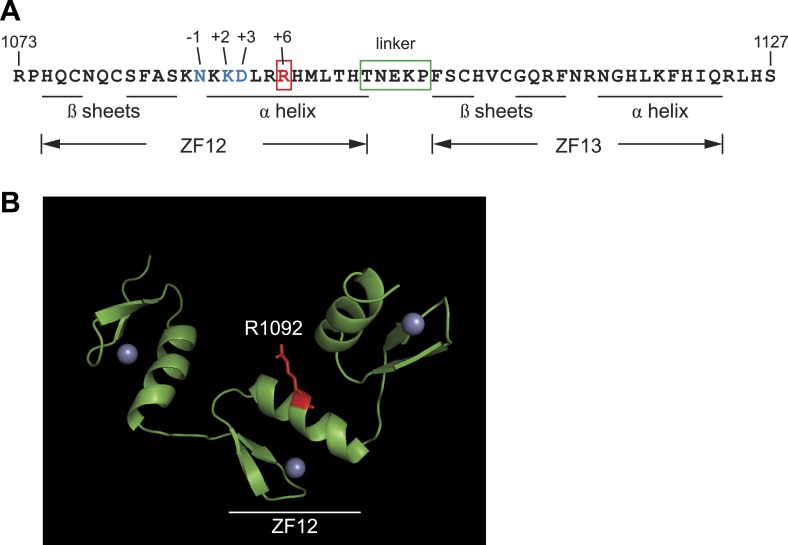
Protein sequence analysis and structural modeling of mutated C2H2
zinc finger in Zfp335.(A) Amino acid sequence of ZF12 and ZF13 (1073–1127 a.a).
Positions −1, +2, +3, and +6, which are thought to mediate base
recognition in DNA-binding C2H2 zinc fingers, are indicated for ZF12.
R1092 (red); canonical C2H2 linker (green box). (B)
Structural model of three zinc fingers near the C-terminus of Zfp335
(1044–1126 a.a). The mutated Arg residue is highlighted in red; gray
spheres represent zinc ions coordinated within the zinc finger fold.